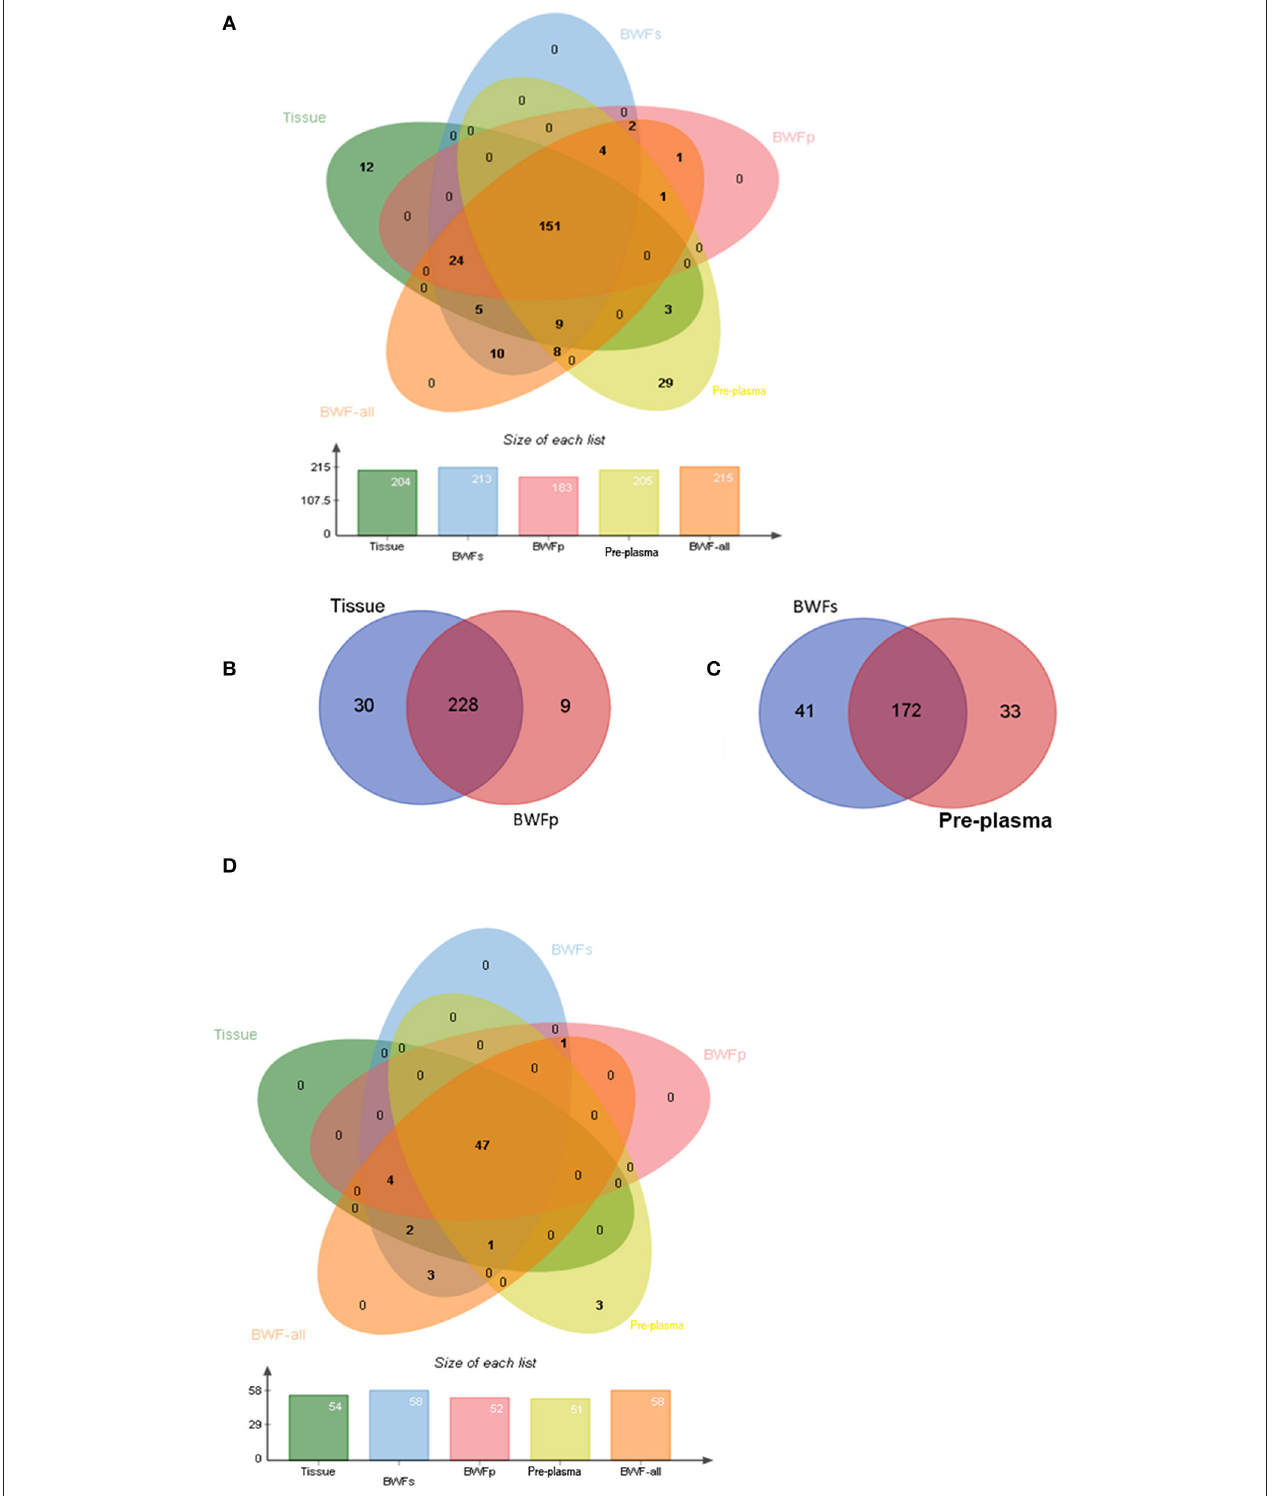
FIGURE 4 | Genomic concordance of different matched types of samples. (A) Mutations detected in four types of sample. (B) Mutations detected in tissues and BWFp samples. (C) Mutations detected in BWFs samples and plasma samples. (D) The concordance between driver gene mutations detected in four types of sample.